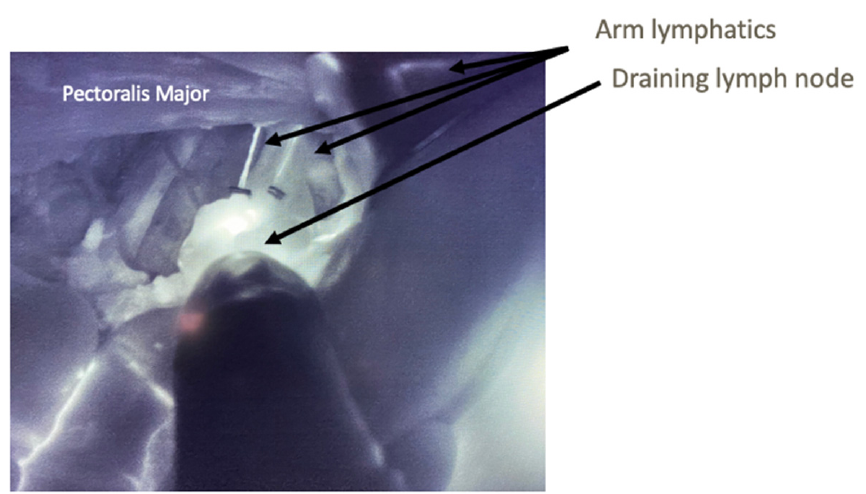
Figure 1. Intraoperative Lymphatic Mapping: Intraoperative view of left axillary lymph node dissection with ICG and SPY. Fluorescence allows for identification of arm lymphatics and draining lymph nodes. Clips are applied as shown to preserve as much length on the lymphatic as possible.